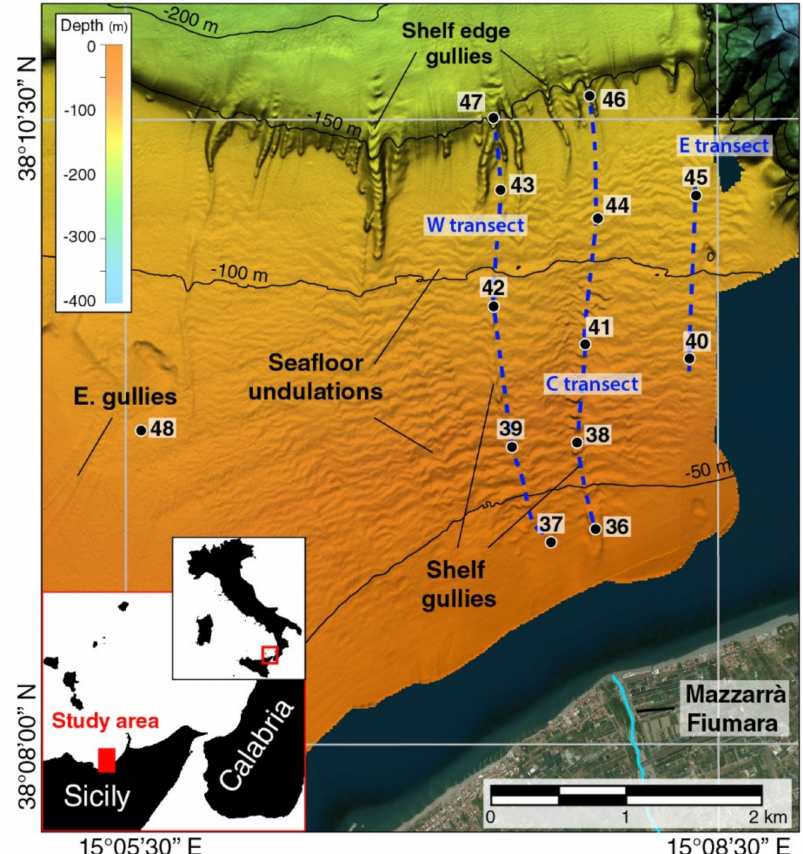
Figure 1. Multibeam shaded relief map of the prodelta of the Mazzarr à Fiumara and location of samples (numbered black dots) along three transects (dashed blue lines indicated as western (W), central (C) and eastern (E)). Bedforms along the shelf in correspondence of the prodelta consist of shallow gullies and sediment undulations. “E. gullies” indicates part of a small gully field associated with the Elicona Fiumara (not shown in the